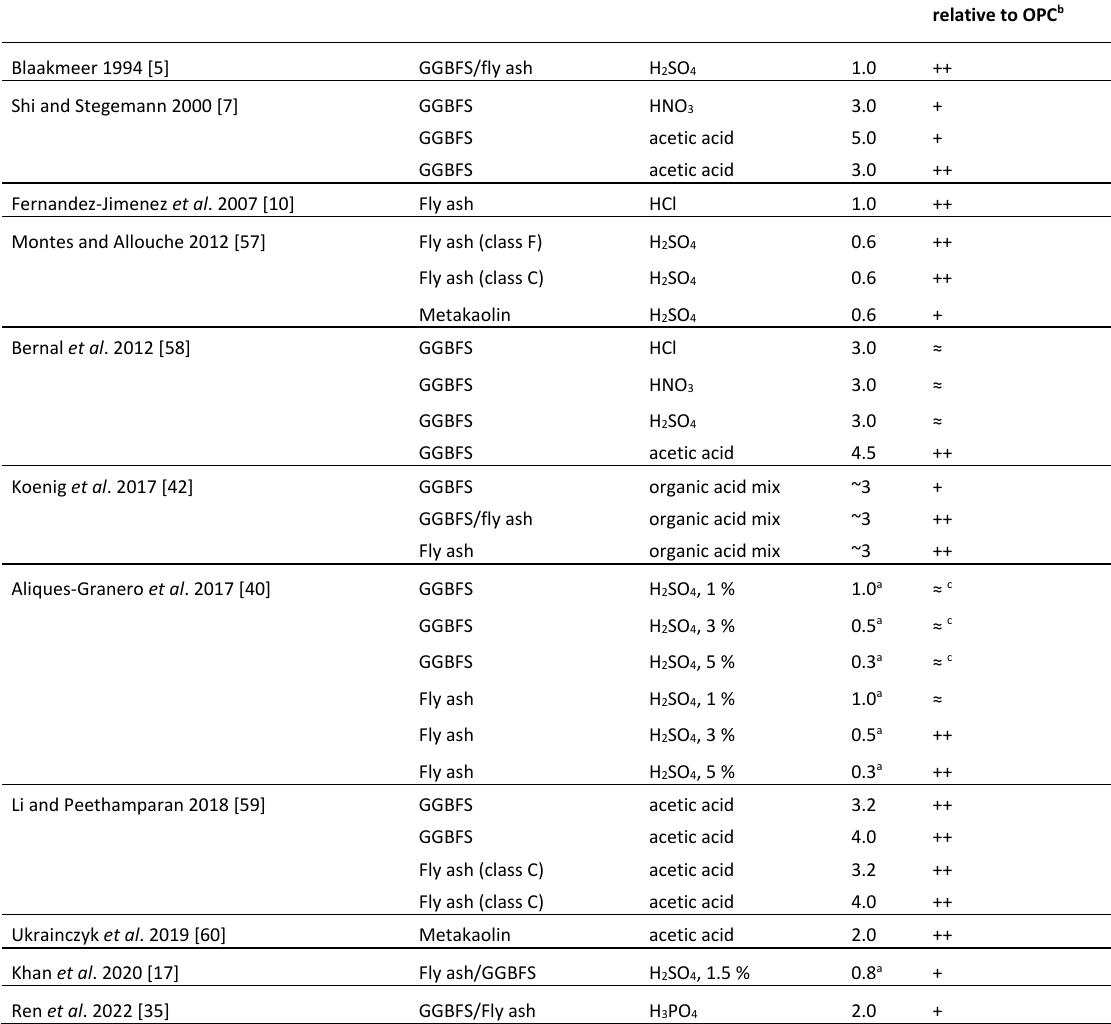
Table 1. Acid resistance of alkali ‐ activated materials (AAMs) compared to ordinary Portland cement (OPC) ‐ based materials.